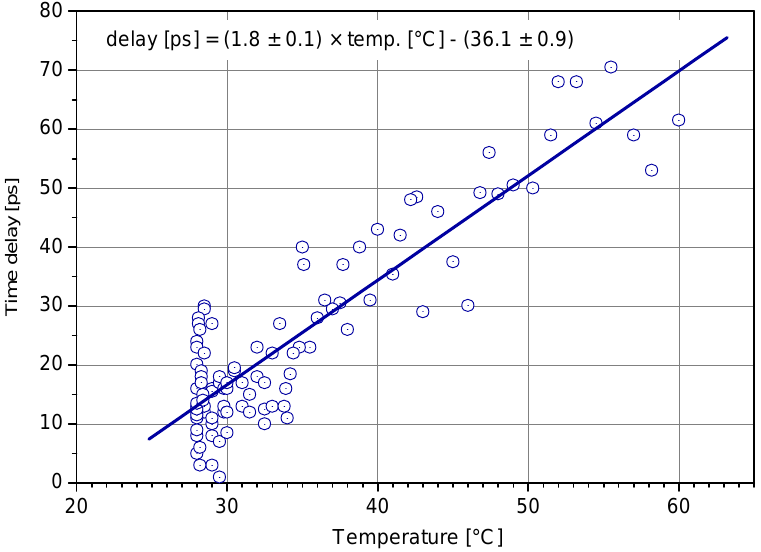
Figure 18. Detection delay against temperature of SPAD for European Laser Timing (ELT)